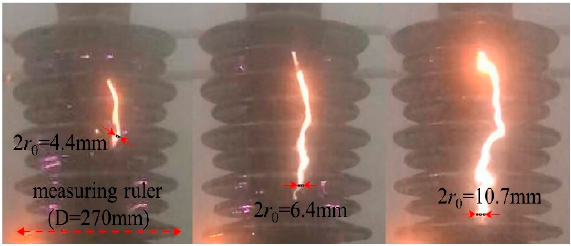
Figure 14. Measurement of arc root radius r 0 .